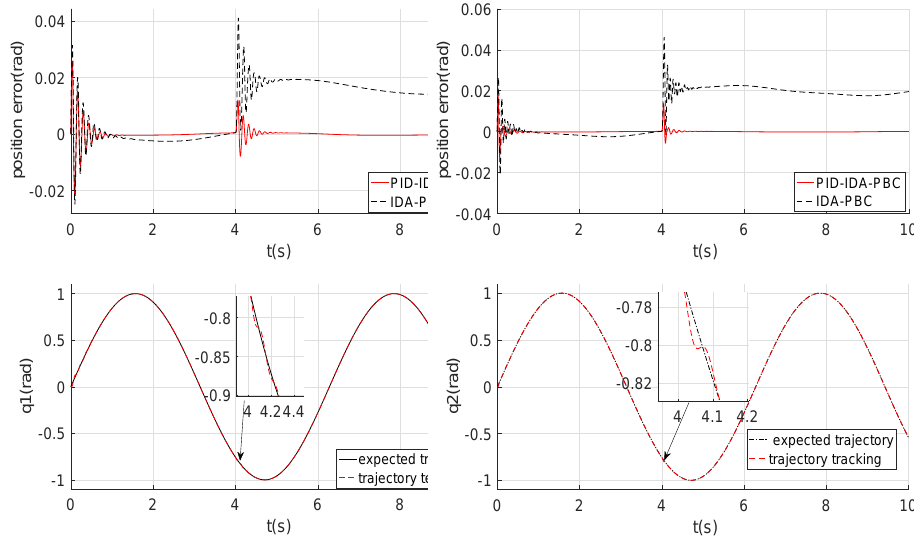
Figure 6. Curves with effect of interference of each